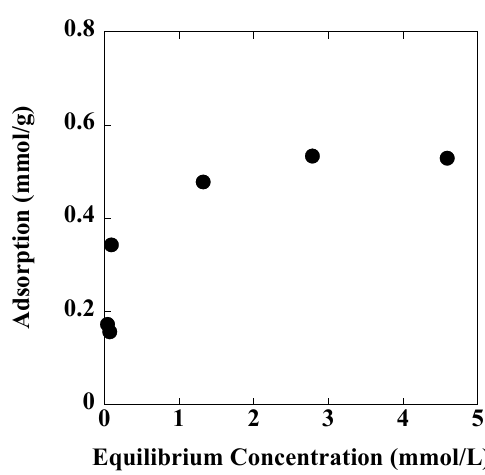
Figure 8. Isotherm of lead ion using Product-K 2 S obtained at 300 °C. Table 2. Parameters and correlation regression for two models, Langmuir and Freundlich. Langmuir